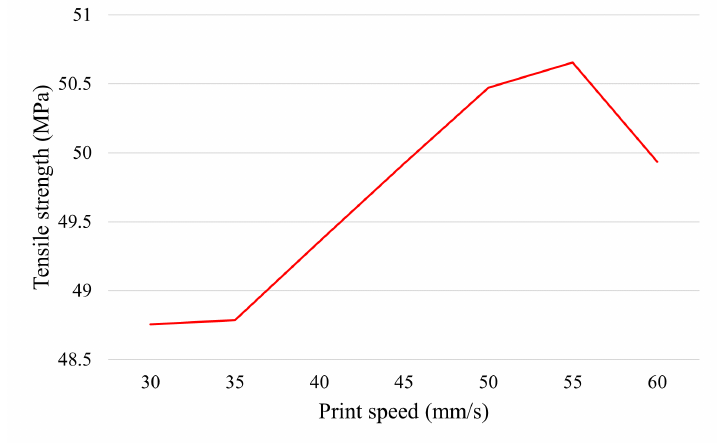
Figure A10. Graphs tensile strength vs. print speed generated from the algorithm.